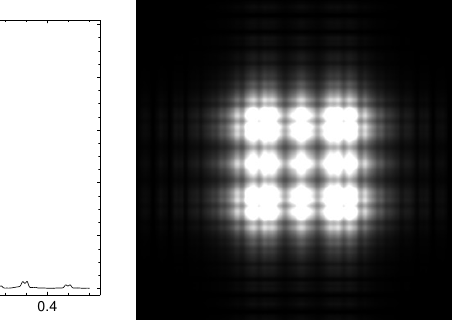
Figure 10. Fractal multiscale solutions of the Schr ¨ odinger equation. Left